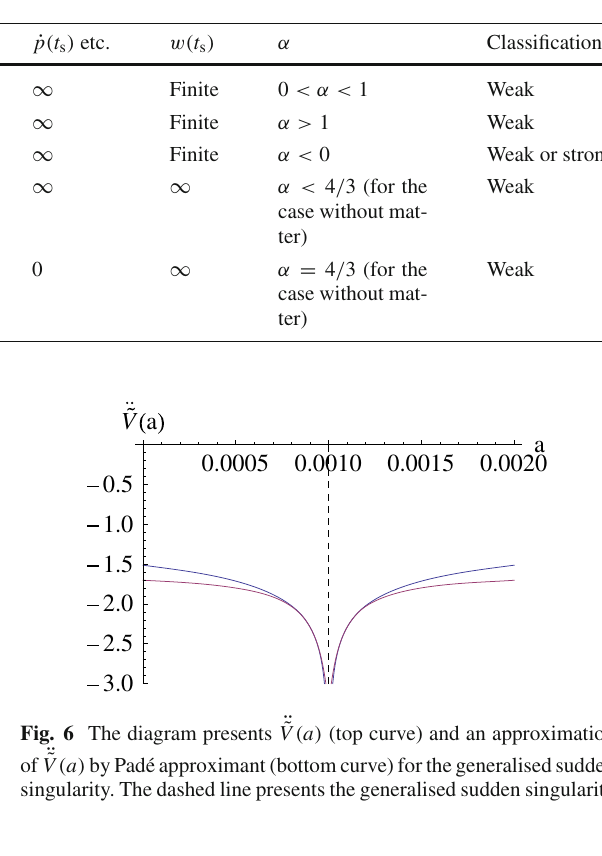
Table 1 Values of critical parameter α for singularities with the finite scale factor [33] for the scale factor a > 0 and the potential V = − 1